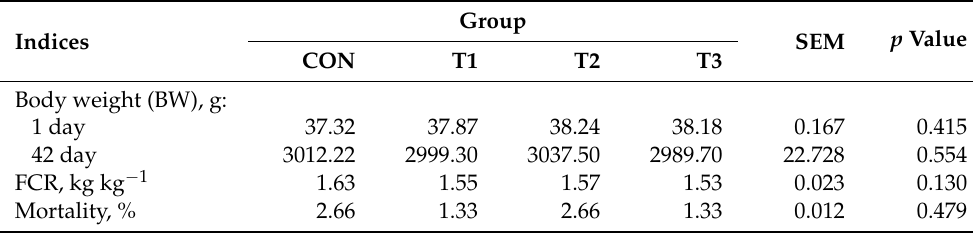
Table 1. Chicken growing